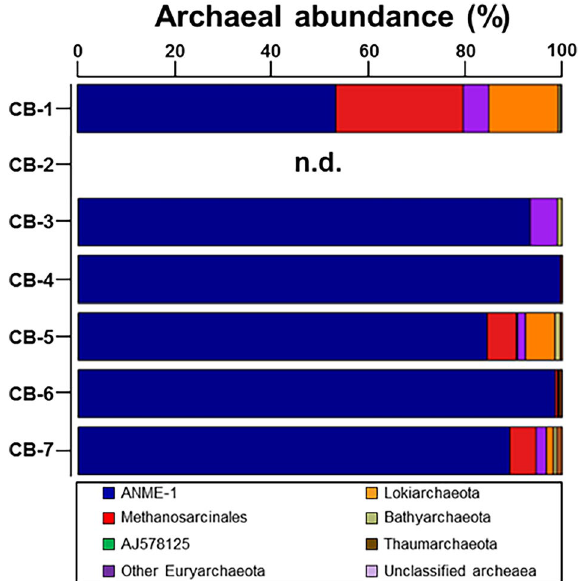
Figure 4. Relative abundances of archaea taxa at the phylum and order level of Euryarchaeota in authigenic carbonates of the Chukchi Borderland (CB). ‘n.d.’ denotes ‘not